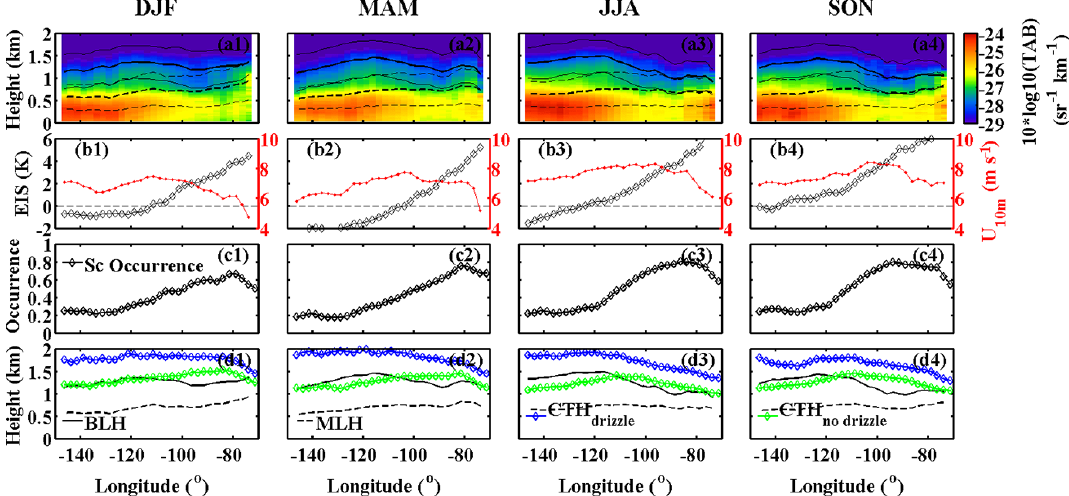
Figure 5. Same as Fig. 4 but for the transect region on the southeastern Pacific Ocean (SPO; dashed box in Fig. 3e) in different